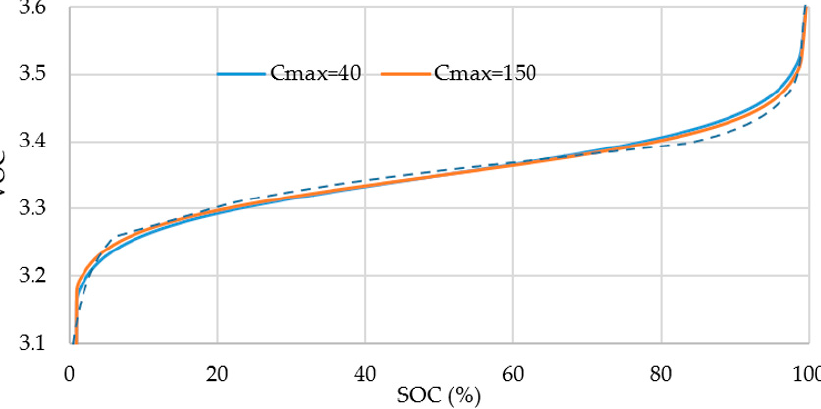
Figure 6. Model fitting of the LiFePO 4 battery compared with the dotted lines obtained from ref.